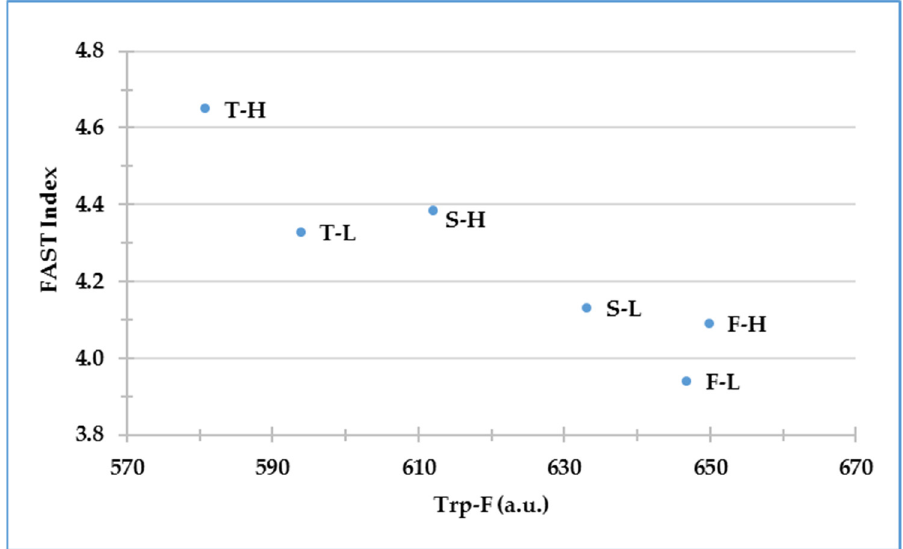
Figure 2. Relation between tryptophan fluorescence (Trp-F) and FAST index in fresh (F), stored (S), and thermized (T) milk subjected to low (L) or high (H) pasteurization.